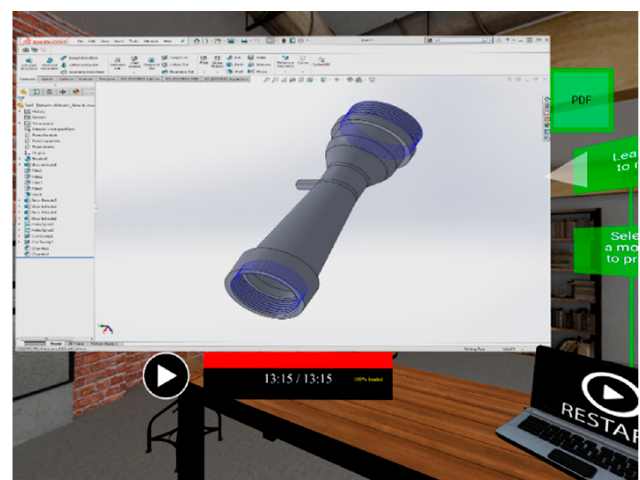
Figure A2. The video of 3D modeling in SolidWorks of the first object.